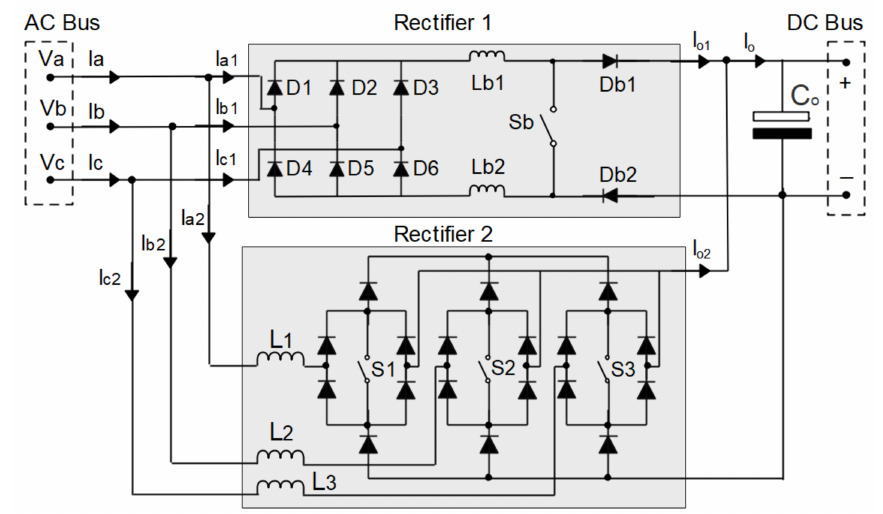
Figure 22. Configuration of the electrical circuit of